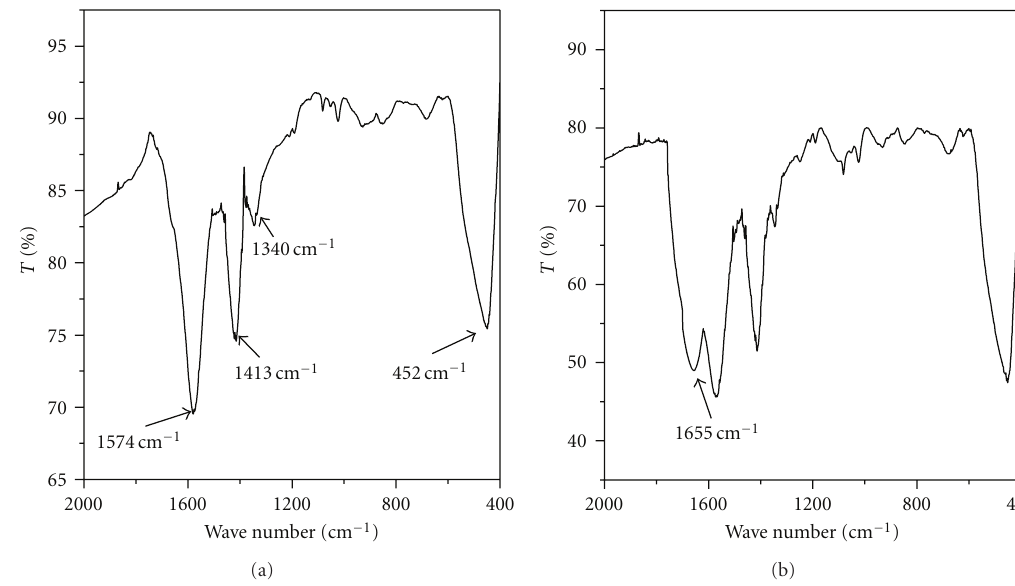
Figure 4: FTIR spectra of (a) ZnO-MB film and (b) GOx/ZnO-MB electrode.